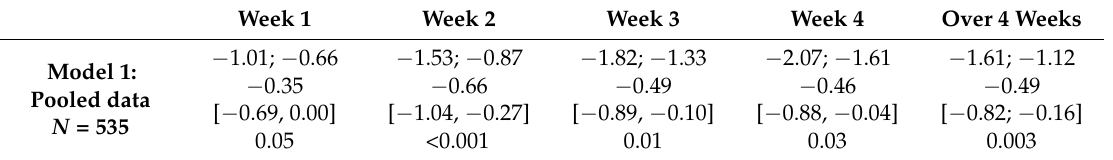
Table 3. LS-Means differences and their 95% confidence interval over 4 weeks and by